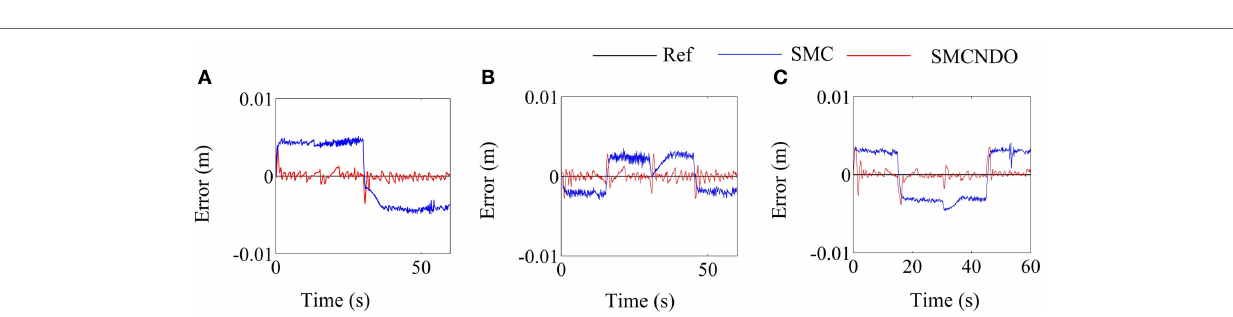
Frontiers in Neurology |